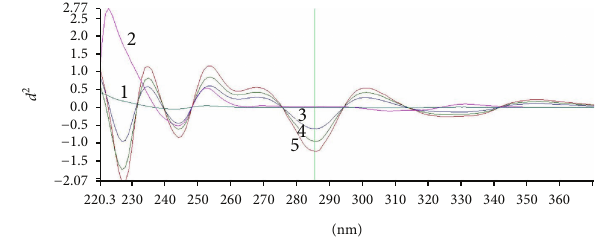
Figure 2: Multiwavelength scans for BZ4, silica gel 60, ethyl acetate- ethanol-water-pH 6 phosphate buffer 14:7 : 5: 1 (v/v/v/v), scanning in reflectance mode.